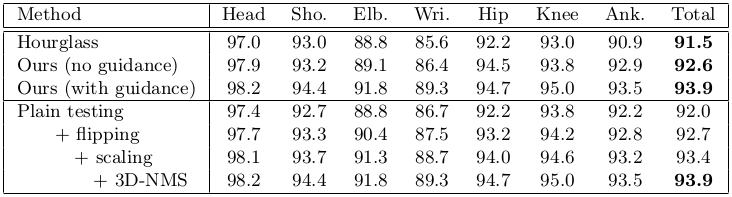
Table from the paper: Knowledge-Guided Deep Fractal Neural Networks for Human Pose Estimation
Table text:
Method
Head
Sho.
Elb.
Wri.
Hip
Knee
Ank.
Total
Hourglass
97.0
93.0
88.8
85.6
92.2
93.0
90.9
91.5
Ours (no guidance)
97.9
93.2
89.1
86.4
94.5
93.8
92.9
92.6
Ours (with guidance)
98.2
94.4
91.8
89.3
94.7
95.0
93.5
93.9
Plain testing
97.4
92.7
88.8
86.7
92.2
93.8
92.2
92.0
+ ﬂipping
97.7
93.3
90.4
87.5
93.2
94.2
92.8
92.7
+ scaling
98.1
93.7
91.3
88.7
94.0
94.6
93.2
93.4
+ 3D-NMS
98.2
94.4
91.8
89.3
94.7
95.0
93.5
93.9